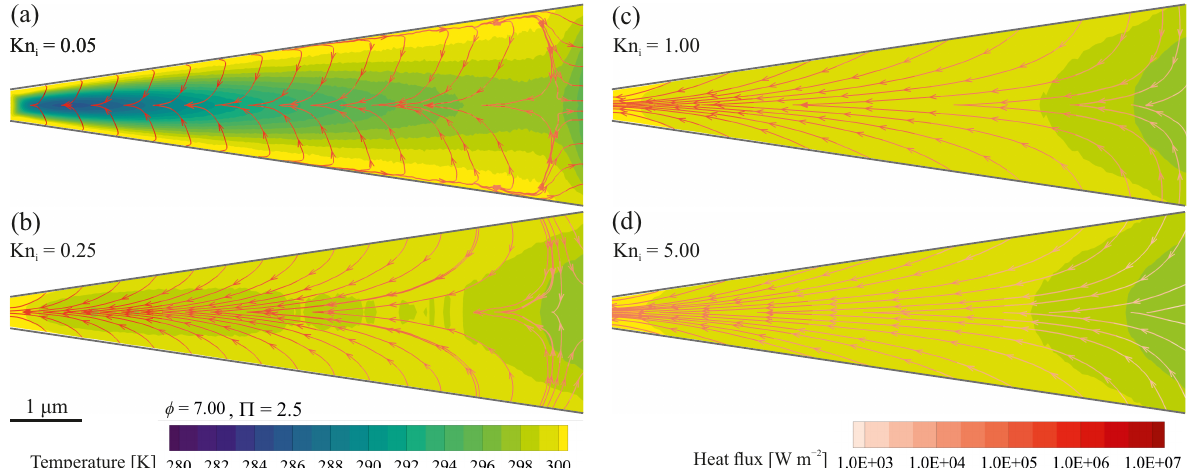
Figure 7. Heatlines (coloured by the magnitude of heat flux) overlaid on contours of dimensionless temperature ( T / T i ) predicted for different inlet Knudsen numbers Kn i . φ = 7.00 and Π =